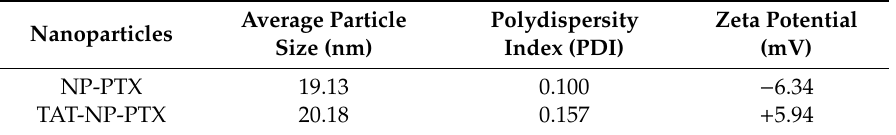
Table 1. Characterization of NP-PTX and TAT-NP-PTX, where PTX refers to Paclitaxel, and TAT is the transactivating transcriptional activator.